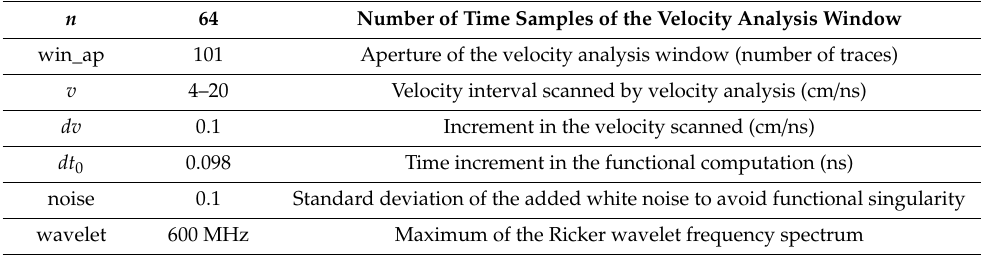
Table 1. Parameters used in the velocity analysis on synthetic data by the coherency